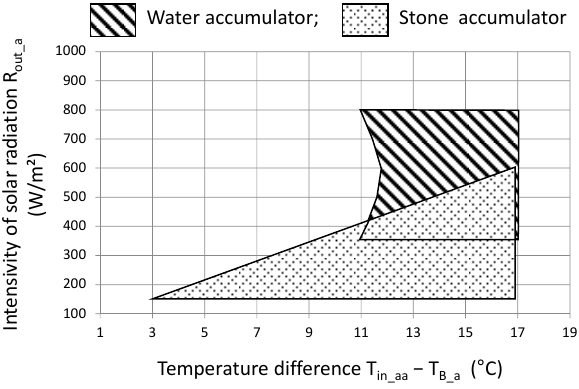
Figure 36. Recommended limits of work parameters of the analyzed accumulators for COP> 3.0.